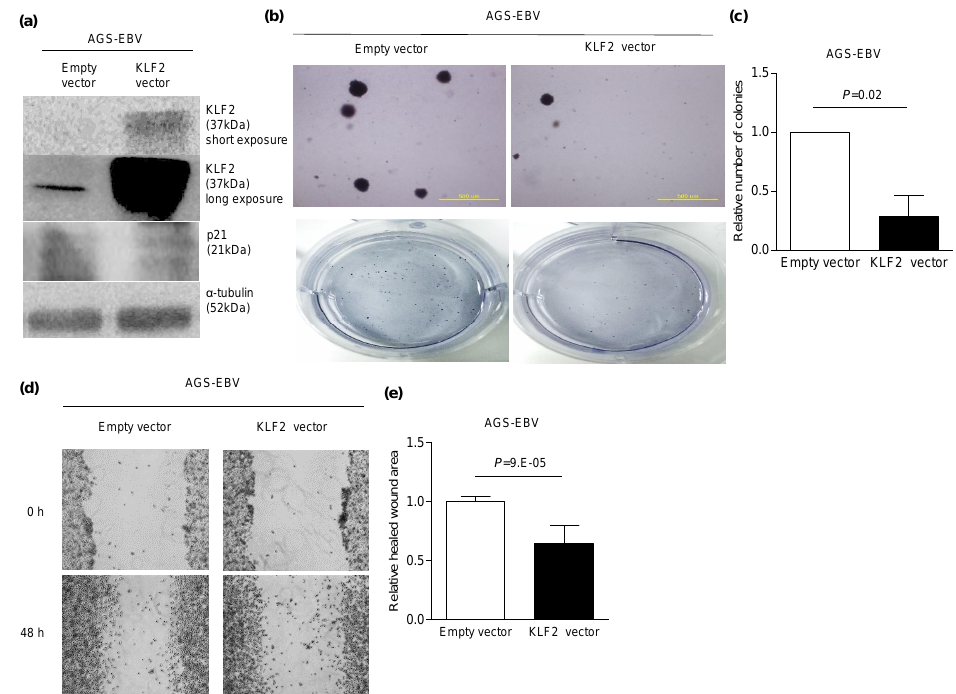
Figure 7. Inhibited tumorigenesis of AGS-EBV cells through KLF2 overexpression. AGS-EBV cells were transfected with either the KLF2 vector or the empty vector, and all experiments were conducted three times independently ( a – e ). ( a ) Western blot analysis was carried out using anti-KLF2 (1:500) antibody. Anti-p21 (1:500) detected the expression of p21 , which is downstream of KLF2 . Anti- α -tubulin antibody was used as a loading control. Long exposure was performed to show that KLF2 was expressed even when the empty vector was delivered. ( b ) To conduct the soft agar colony formation assay, transfected AGS-EBV cells were harvested after 24 h and seeded in agar. Cells placed in agar were observed after 4-6 weeks in three independent experiments. Upper panels were observed with microscope IX70 through a × 40 objective. Lower panels show the images taken with a camera. ( c ) Colonies were quantified using the Image J software. Error bars indicate SD ( n = 3). ( d ) Wound-healing assay was performed three times independently in AGS-EBV cells transfected with 500 ng of the KLF2 expression vector or the empty vector. ( e ) Healed wound area was measured by Image J software. Error bars indicate SD ( n =